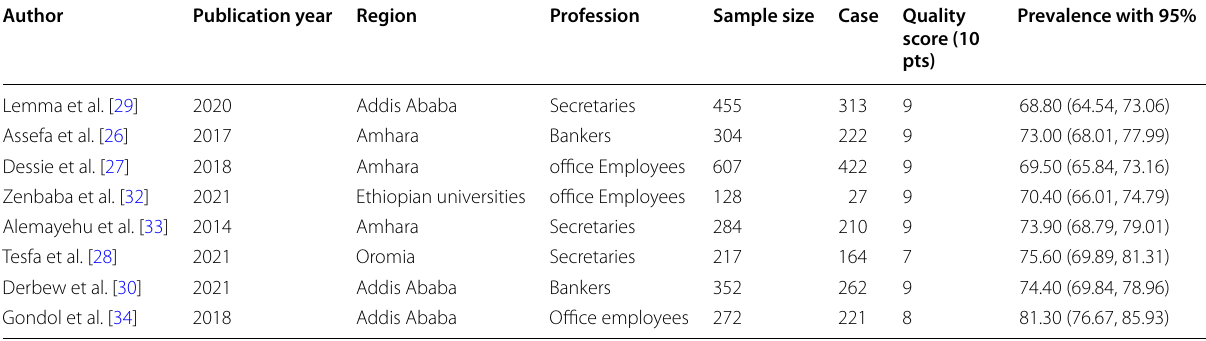
Table 2 Descriptive summary of eight studies reporting the prevalence of computer vision syndrome and associated factors among employees who use the computers in Ethiopia included in the systematic review and